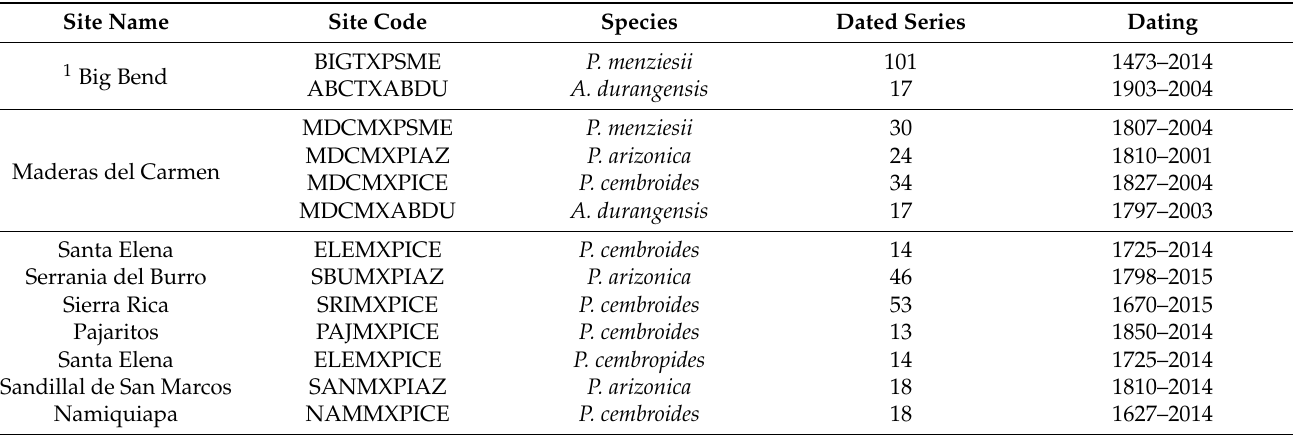
Figure 1. The locations of tree-ring chronologies from the borderland are numbered and plotted (red triangles). The three large protected natural areas in the Big Bend region of the Rio Brave are also mapped along with the international frontier and the municipal divisions in Chihuahua and Coahuila. Table 1. Network of ring-width chronologies along the international border between Texas and the Mexican states of Chihuahua and Coahuila.